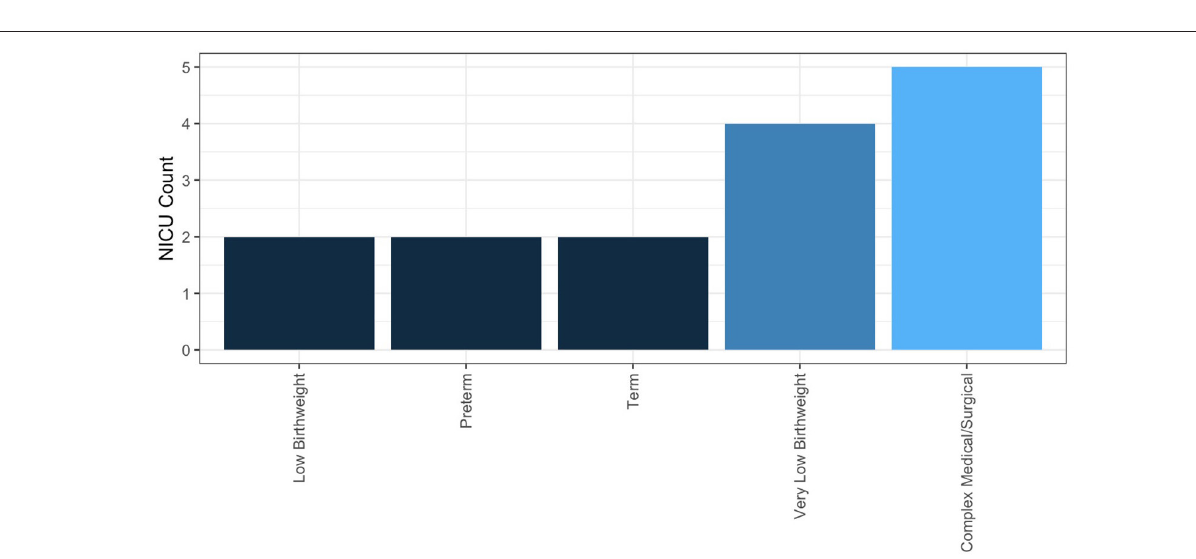
FIGURE 6 | NICUs are using human milk analysis in a wide range of infant populations.